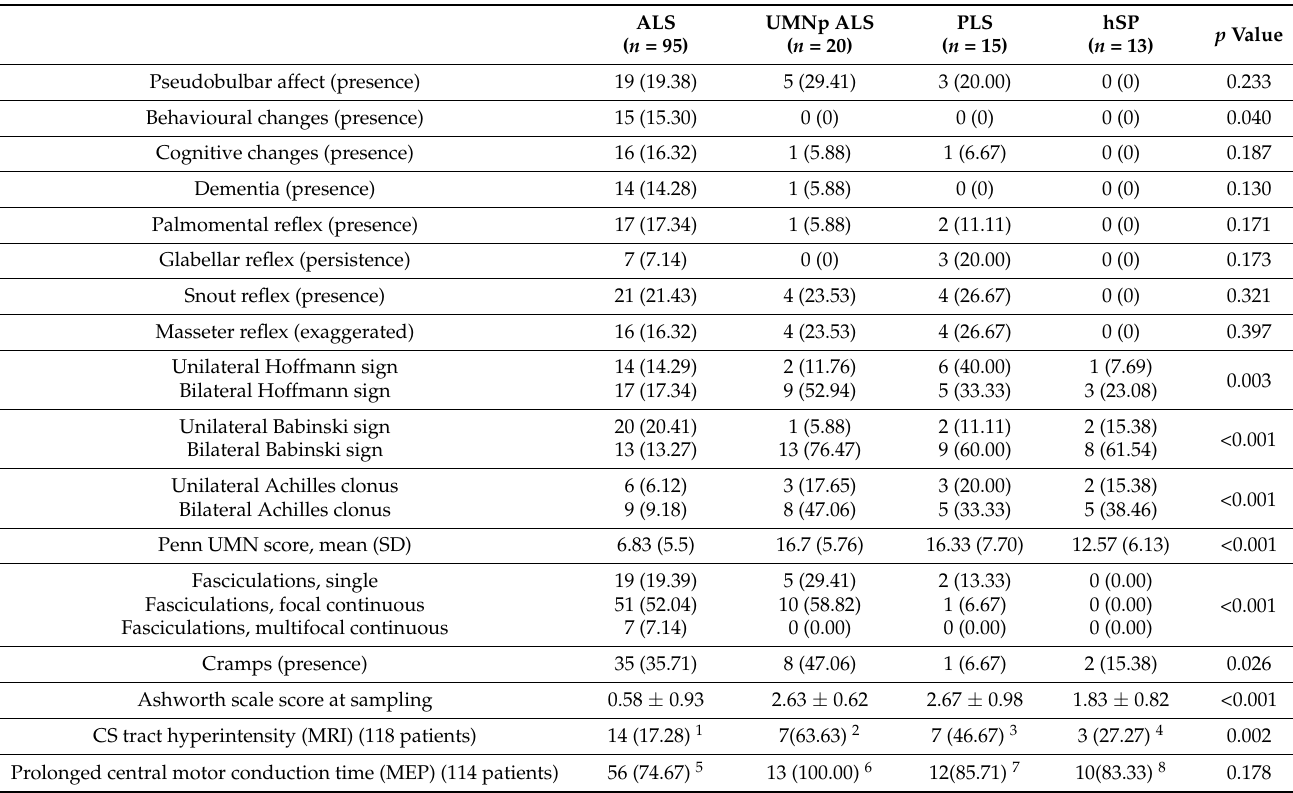
Table 2. Clinical and instrumental signs of MN involvement across different MND.